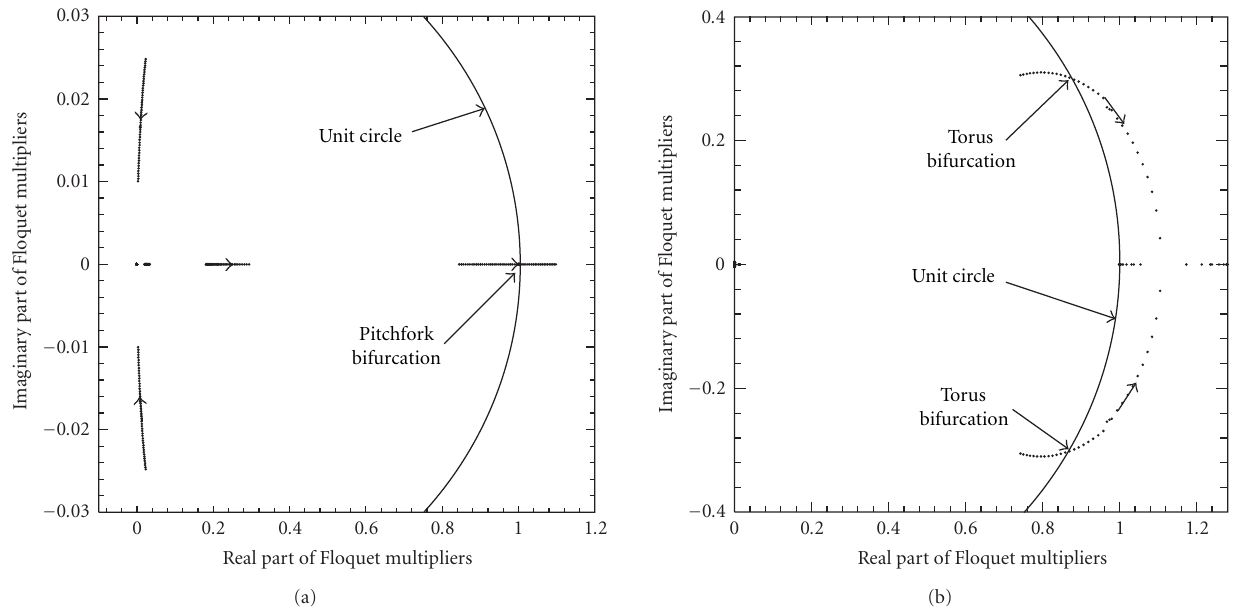
Figure 4: The variation of Floquet multipliers around two points in Figure 3; (a) pitchfork bifurcation point 2, (b) bifurcation into torus point 7.